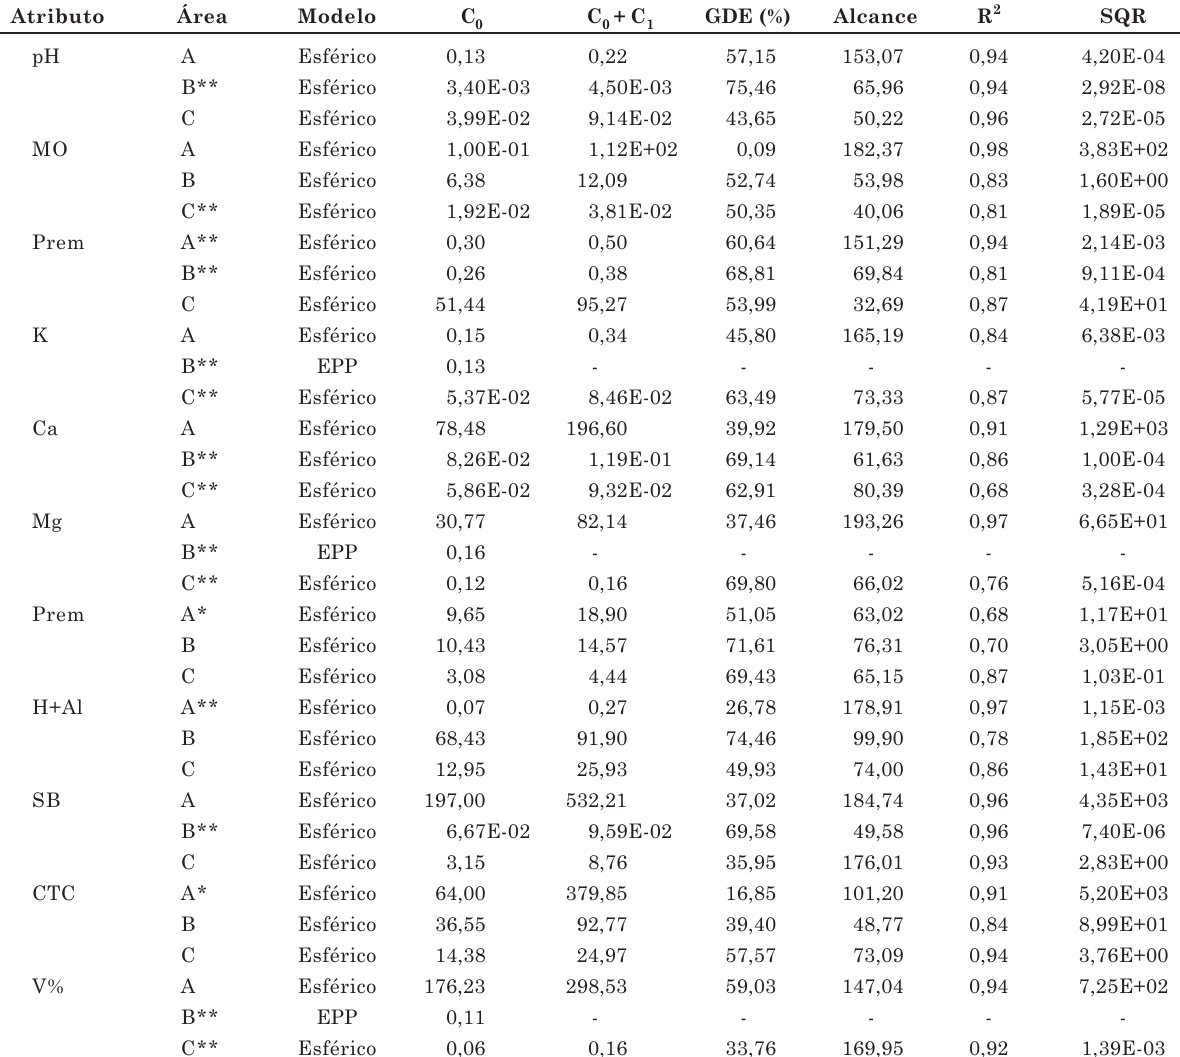
Quadro 5. Modelos e parâmetros ajustados aos variogramas experimentais dos atributos químicos dos